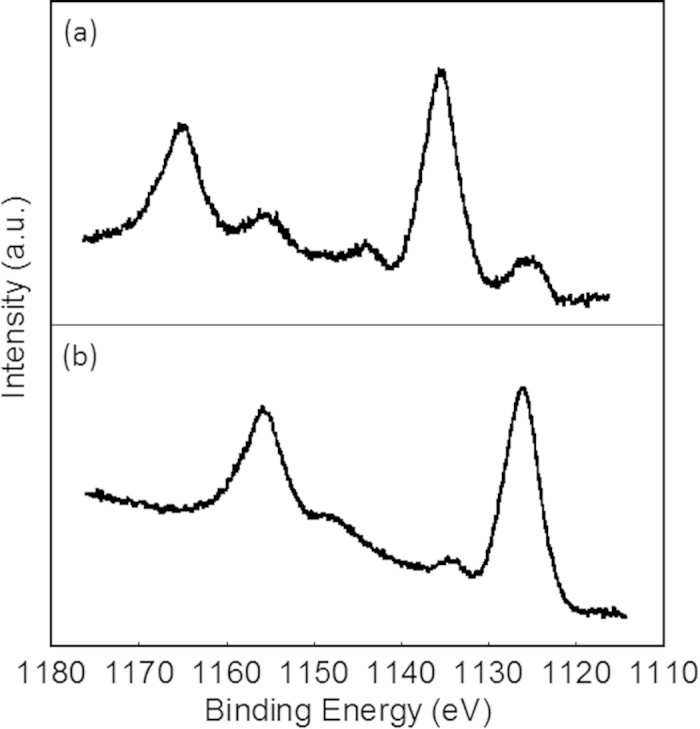
Eu3d XPS bands ofa) as-prepared and b) sintered SiO2/Eu/phen nanoparticles.